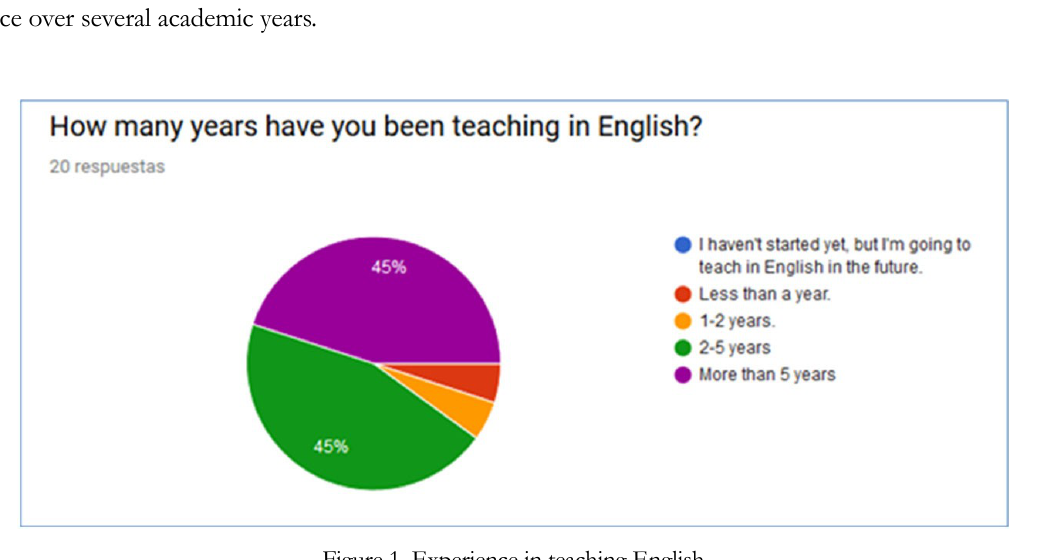
Figure 1. Experience in teaching English